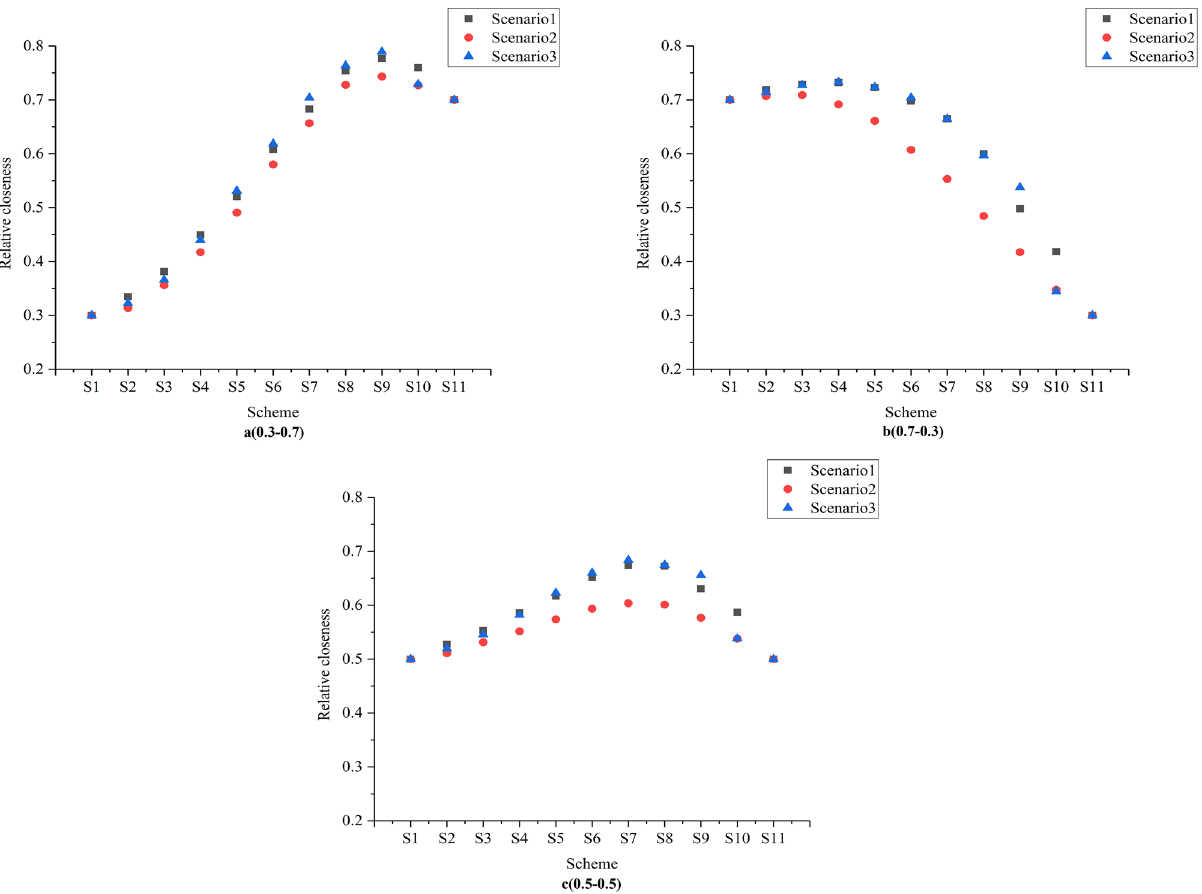
Figure 8. Relative posting values for the three weighting sets (0.3–0.7 means that the weights of objective function one and objective function two are 0.3 and 0.7